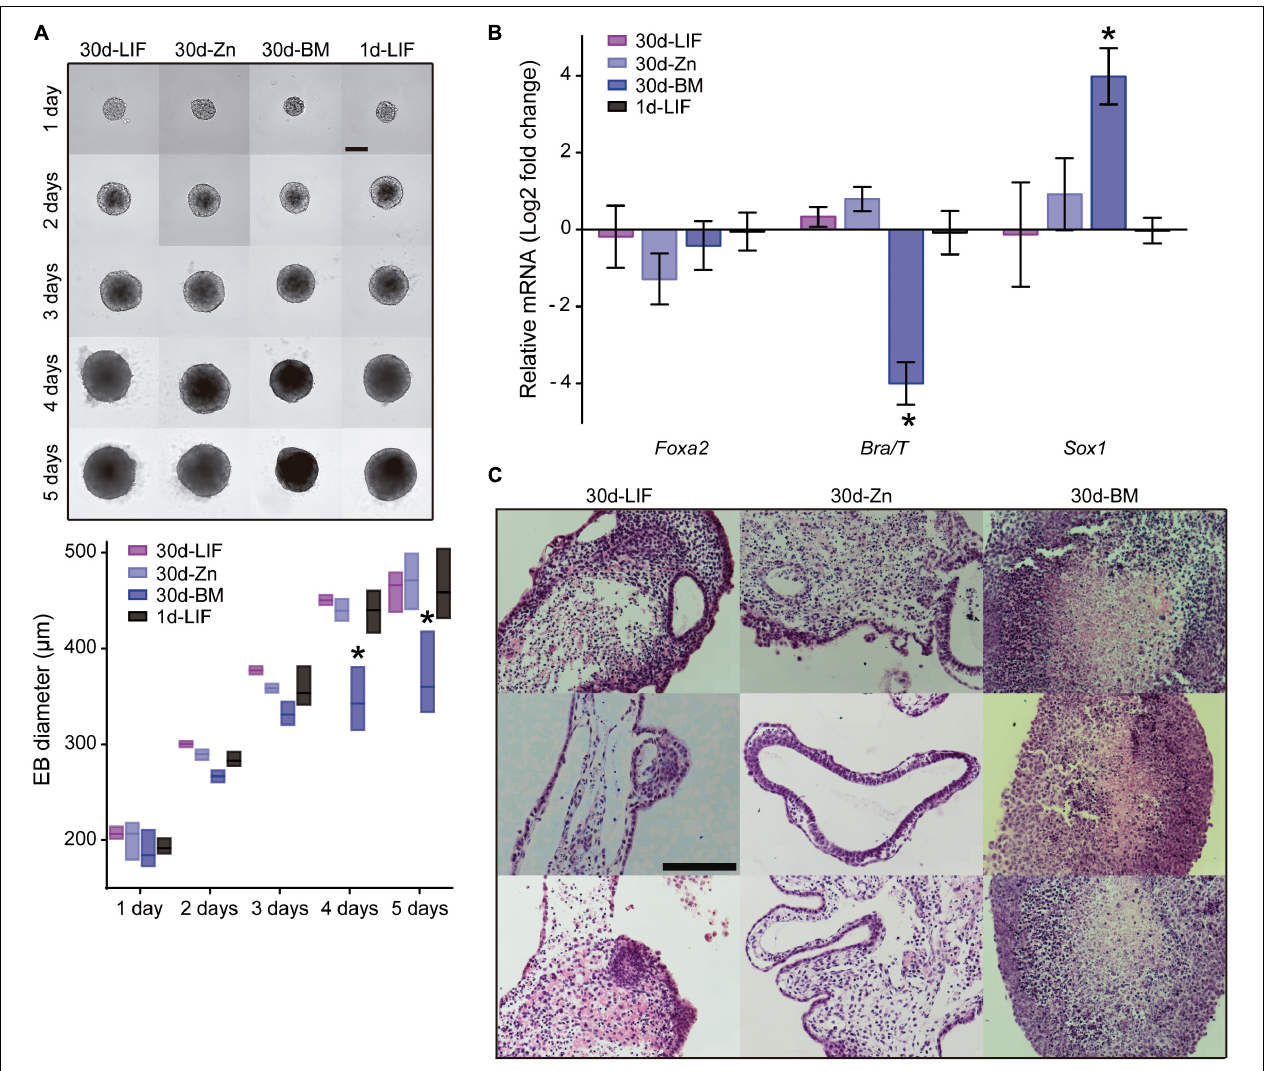
FIGURE 5 | Role of zinc in spontaneous embryoid body differentiation after 30 days of culture. (A) Embryoid body formation of ESCs cultured for 30 days in BM and a medium supplemented with LIF or 100 µ M Zn 2 + . New EBs formed from low passage ESCs (not previously cultured for 30 days under different conditions) were included as a control of embryoid body formation (1d-LIF). Measurements of EB diameters ( n = 9). Scale bar: 200 µ m. (B) Evaluation of spontaneous differentiation of EBs formed after culture of ESCs for 30 days in BM and a medium supplemented with LIF or 100 µ M Zn 2 + . qPCR detection of primary germ layer markers: endoderm ( Foxa2 ), mesoderm ( Brachyury/T ) and ectoderm ( Sox1 ). Gapdh was used as housekeeping gene ( n = 4). (C) Hematoxylin/eosin staining of histological sections of EBs after 15 days of culture. EBs were formed after culture of ESCs for 30 days in BM, medium supplemented with LIF or 100 µ M Zn 2 + . Scale bar: 100 µ m. Significant differences were determined by ANOVA test: ∗ p <